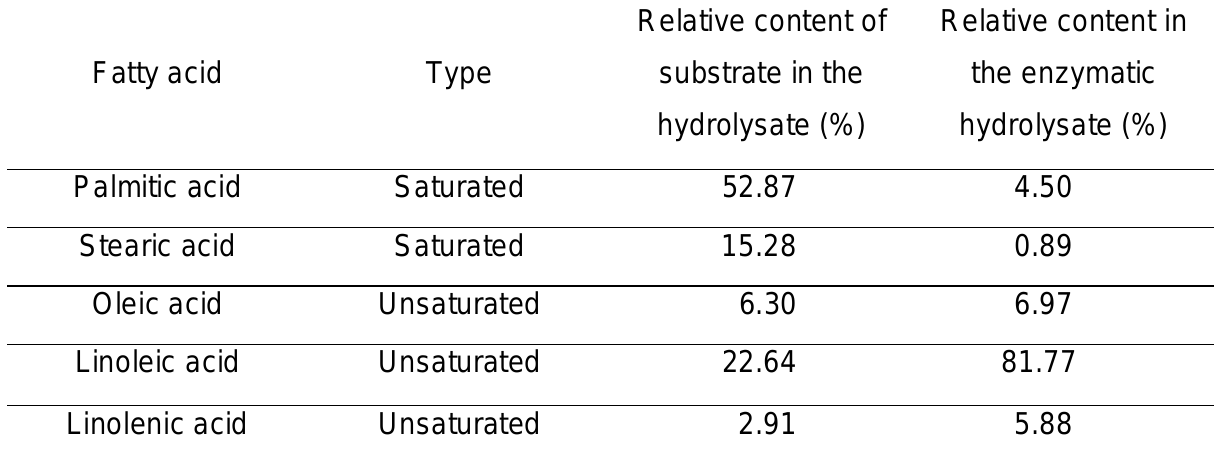
Table 1: Relative contents of fatty acids obtained from lecithin basic hydrolysis and enzymatic